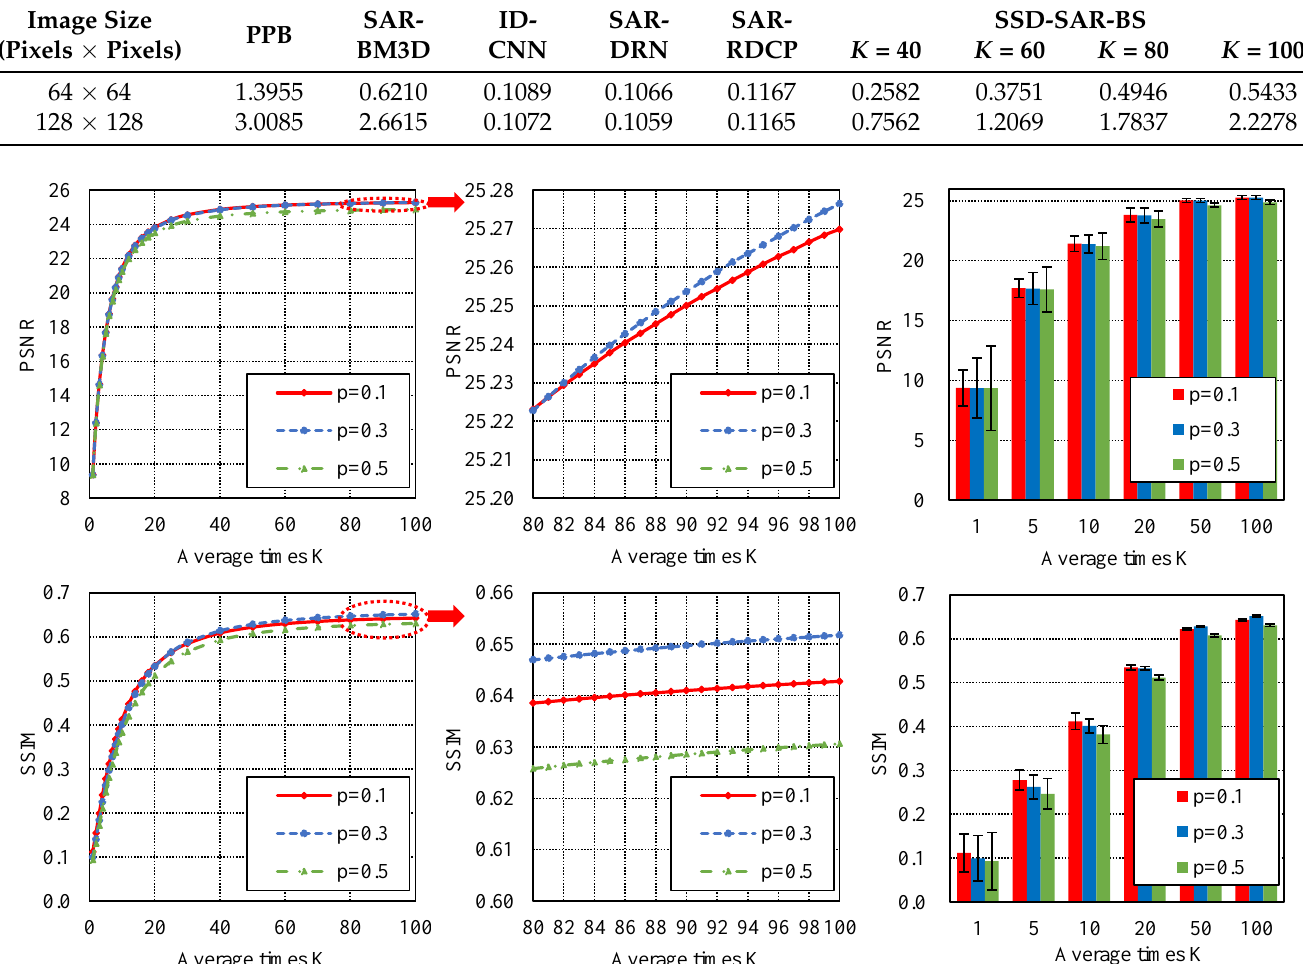
Table 4. Runtime (seconds) comparison.